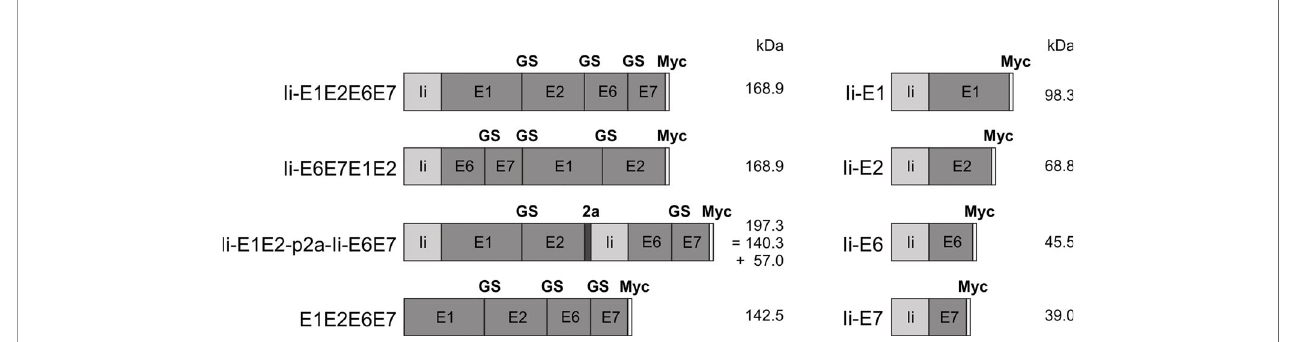
FIGURE 1 | Schematic representation of the conceived MfPV3 antigen variants. MfPV3 antigens were designed as fusion proteins comprising either E1, E2, E6 and E7 altogether, or E1 plus E2 and E6 plus E7 fusion proteins linked by a p2a peptide, and fused to the MHC-II invariant chain (Ii), respectively. For reference, E1, E2, E6, and E7 were fused as single open reading frames without the Ii coding sequence. Calculated molecular weights are indicated (kDa). Ii, MHC-II associated invariant chain; GS, glycine-serine-linker; 2a, p2a peptide for cotranslational separation; Myc, myc-tag sequence for antibody detection; kDa, kilo